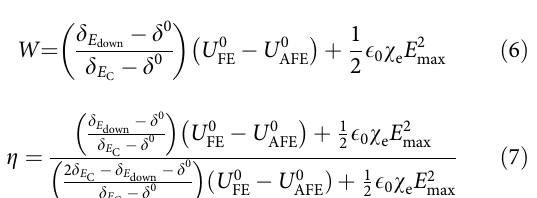
NATURE COMMUNICATIONS|8:15682|DOI: